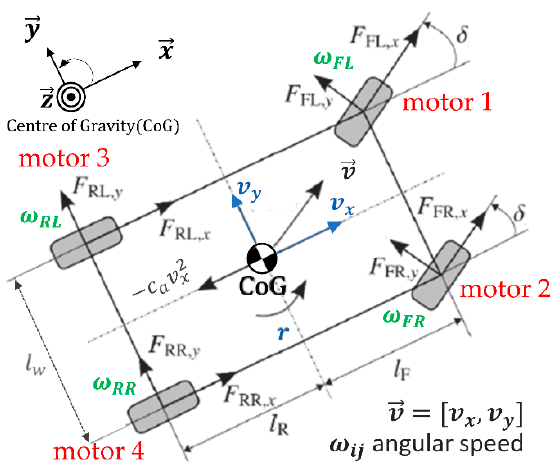
Figure 1. Full-track electric vehicle with redundant actuators (4IWMs).